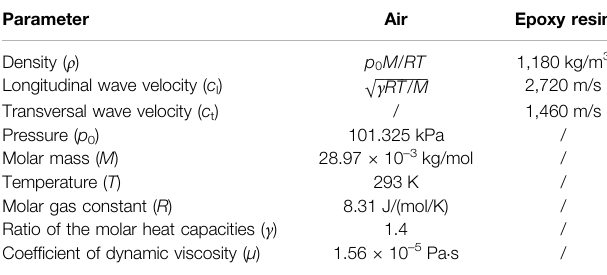
TABLE 1 | Material parameters.